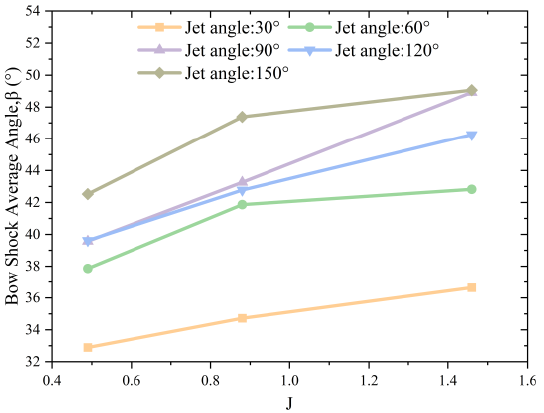
Figure 17. Jet momentum flux ratio — average angle of the bow shock.